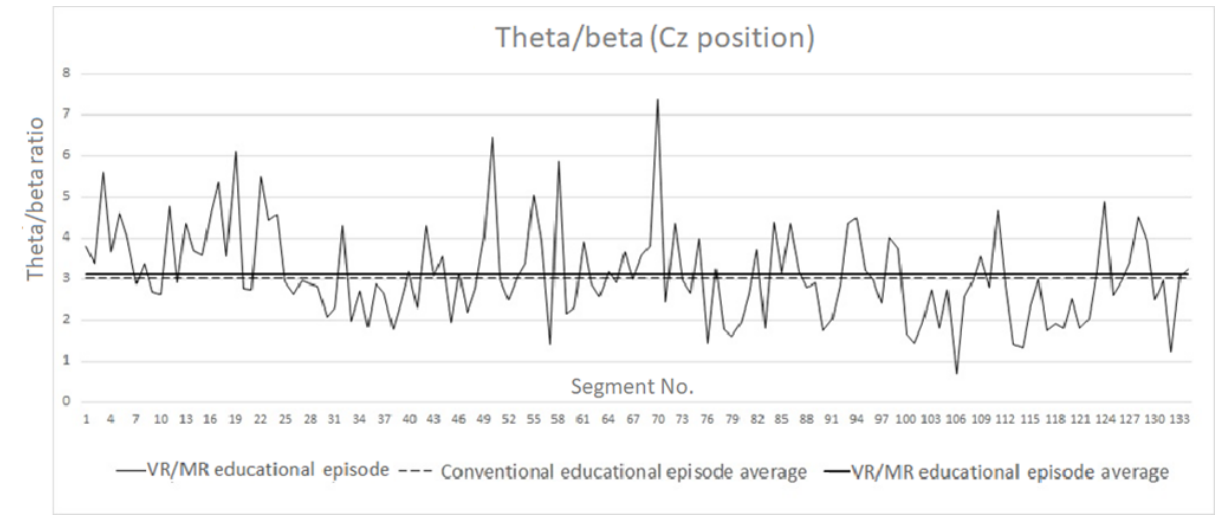
Figure 5. Theta/beta ratio segment plot for the VR/MR educational episode for the Cz position. MR: mixed reality; VR: virtual reality.